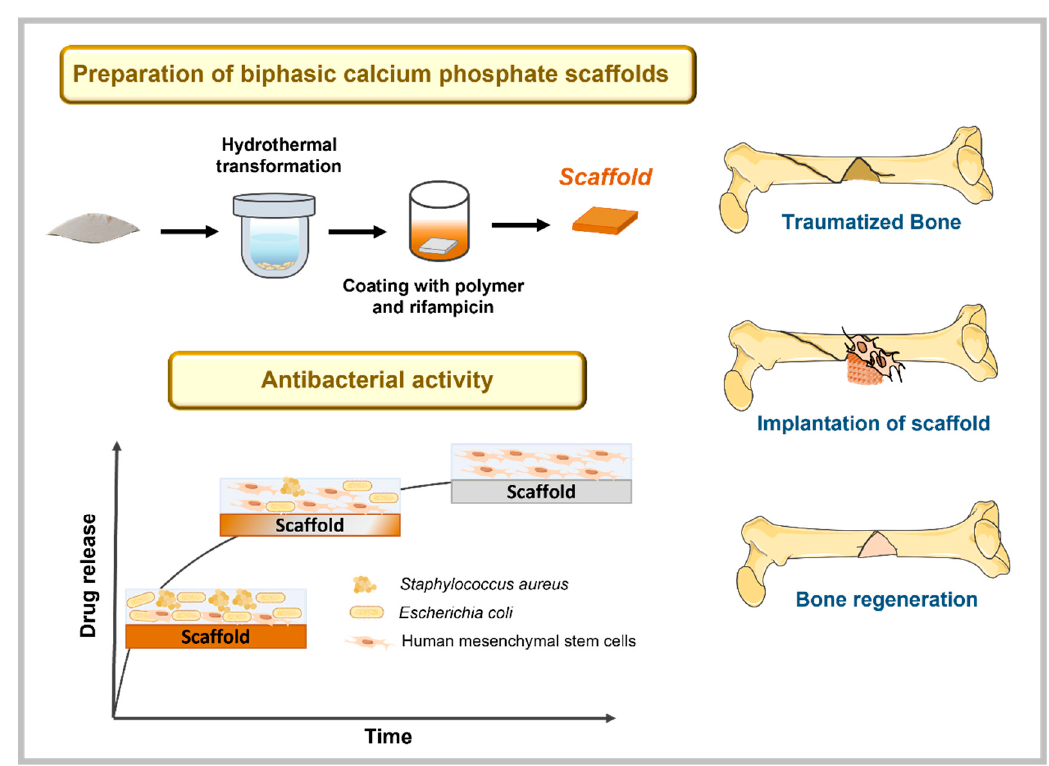
Figure 1. Overall strategy for the preparation of multifunctional biphasic calcium phosphate scaffolds coated with polymeric materials and with drug delivery properties.